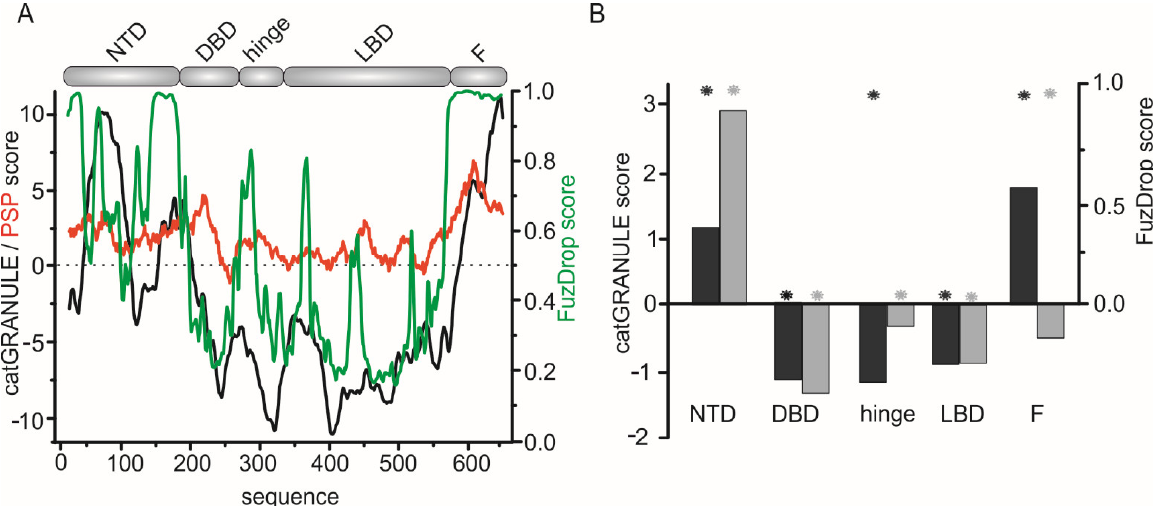
Figure 4. In silico analyses of the phase separation propensity of AaEcR. ( A ) Analysis performed for the sequence of EcR from A. aegypti . The propensity profiles refer to a scheme depicting the modular structure of the protein (above). Values above 0 indicate a putative tendency for provoking LLPS predicted by catGRANULE (black) and PSP (red) predictors, whereas values above 0.5 indicate a probable tendency predicted by FuzDrop (green). ( B ) Averaged propensity score values obtained for fragments of the EcR from A. aegypti (GenBank: AAA87394.1), and D. melanogaster (Uniprot: P34021). The black ( A. aegypti ) and grey ( D. melanogaster ) bars show the analysis performed using the catGRANULE predictor, asterisks show the results of an analysis performed using FuzDrop. The used predictors are available at: